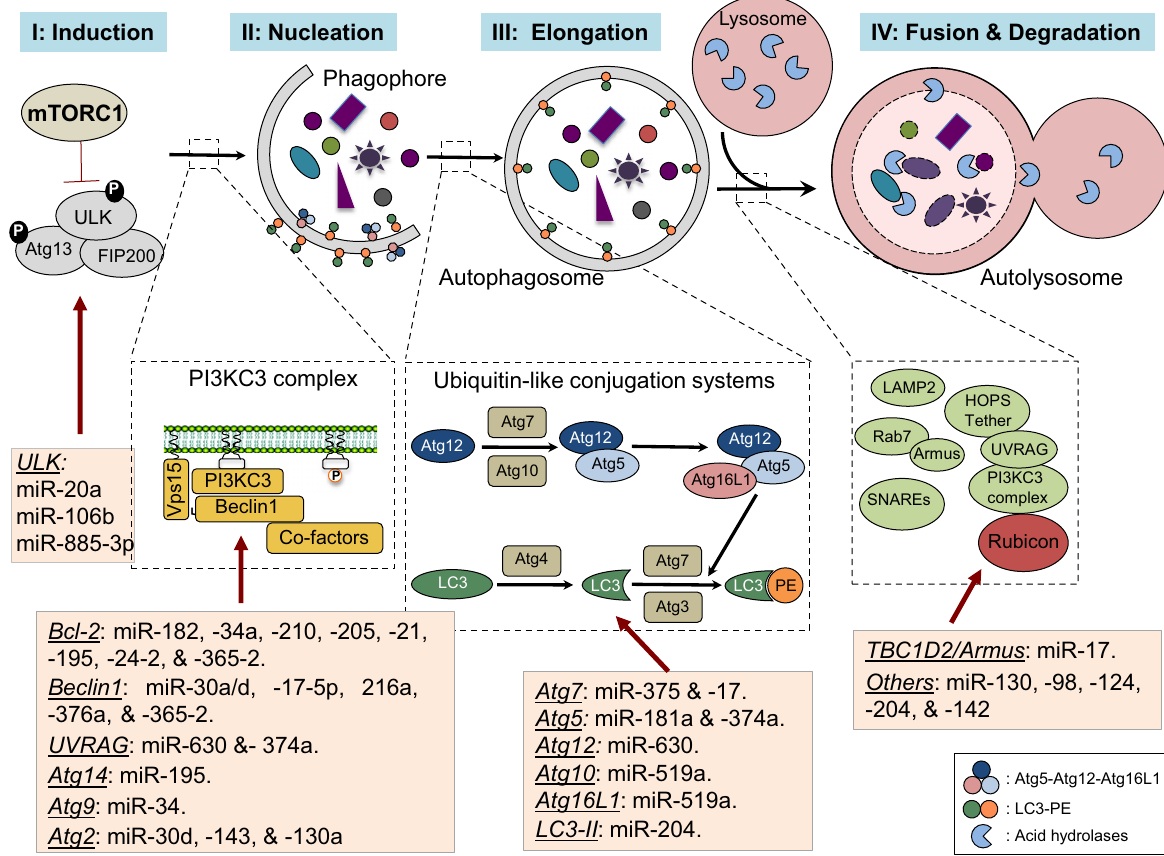
Figure 1 . Schematic representation of the core autophagy pathway and its regulation by miRNAs. Autophagy proceeds through a series of steps including induction, vesicle nucleation, membrane elongation, and autophagosome maturation into the lysosome for degrada- tion and recycling. miRNAs regulation occurs at each dynamic step. Autophagy induction is directly and tightly controlled by the ‘ nutri- ent sensor ’ mTORC1, which under nutrient-rich condition precludes the assembly and the activation of the autophagy-initiating ULK complex comprising ULK1/2, Atg13, and FIP200 (Step 1). mTORC1 is inactivated in response to various stimuli (for instance, starvation, hypoxia), which enables the activation of the ULK complex and triggers the autophagy cascade. MiR-20a, miR106b, and miR-885-3P target ULK1/2 and suppress autophagy. Phagophore nucleation, which is con fi ned to the phosphatidylinositol-3-phosphate (PI3P)- containing vesicles, is driven by the Beclin1-associated PI3KC3 complex (Step 2). The activity of this kinase complex is suppressed by the anti-apoptotic Bcl-2 proteins, a functional target of multiple miRNAs such as miR-182, miR-34a, miR-210, miR-205, miR-21, miR-195, miR-24-2, and miR-365-2. Beclin1 can also be targeted by miR-30a, miR-30d, miR-17-5p, miR-216a, miR-376a, and miR-365-2. In addi- tion, UVRAG is a direct and functional target of miR-630 and miR-374a, while Atg14 being inhibited by miR-195. Autophagosome membrane elongation involves two ubiquitin-like conjugation systems: one is Atg12-Atg5 conjugation and the other is LC3-phosphatidy- lethanolamine (PE) conjugation, the latter of which is sequentially processed by Atg4, Atg7, and Atg3 (Step 3). Atg7 can be suppressed by miR-375 and miR-17. LC3-II levels are posttranscriptionally controlled by miR-204. Fusion of the autophagosome with the lysosome signi fi es the maturation stage of the autophagy pathway, a step that involves multiple membrane fusion factors and is negatively regulated by the Rubicon complex (Rubicon-UVRAG-Beclin1-PI3KC3-p150). Finally, the encapsulated contents, together with the inner membrane of the autophagosome, undergo breakdown by lysosomal